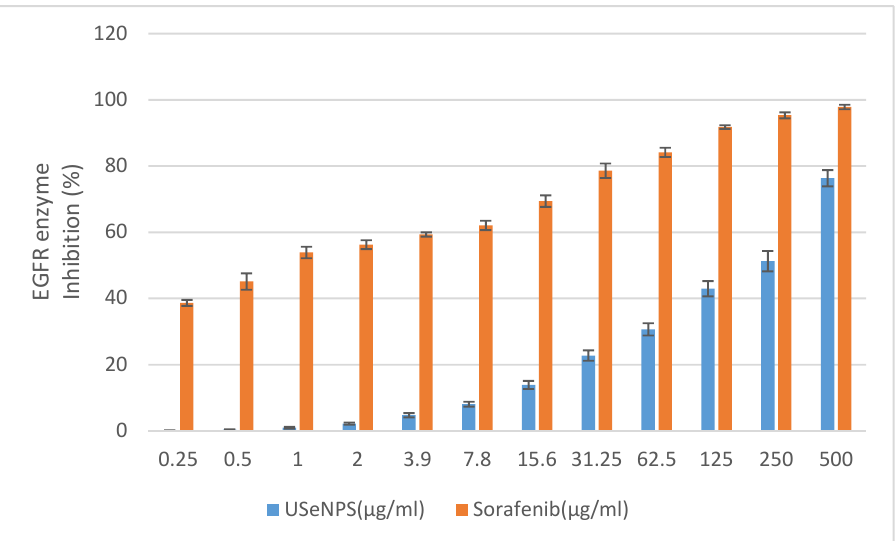
Figure 12. Effect of USeNPS on epidermal growth factor receptors enzyme (EGFR enzyme) activity with IC 50 = 230.79 ± 3.47 µg/mL. and IC 50 = 0.76 ± 0.18 µg/mL. For USeNPS and Sorafenib (ref. drug).